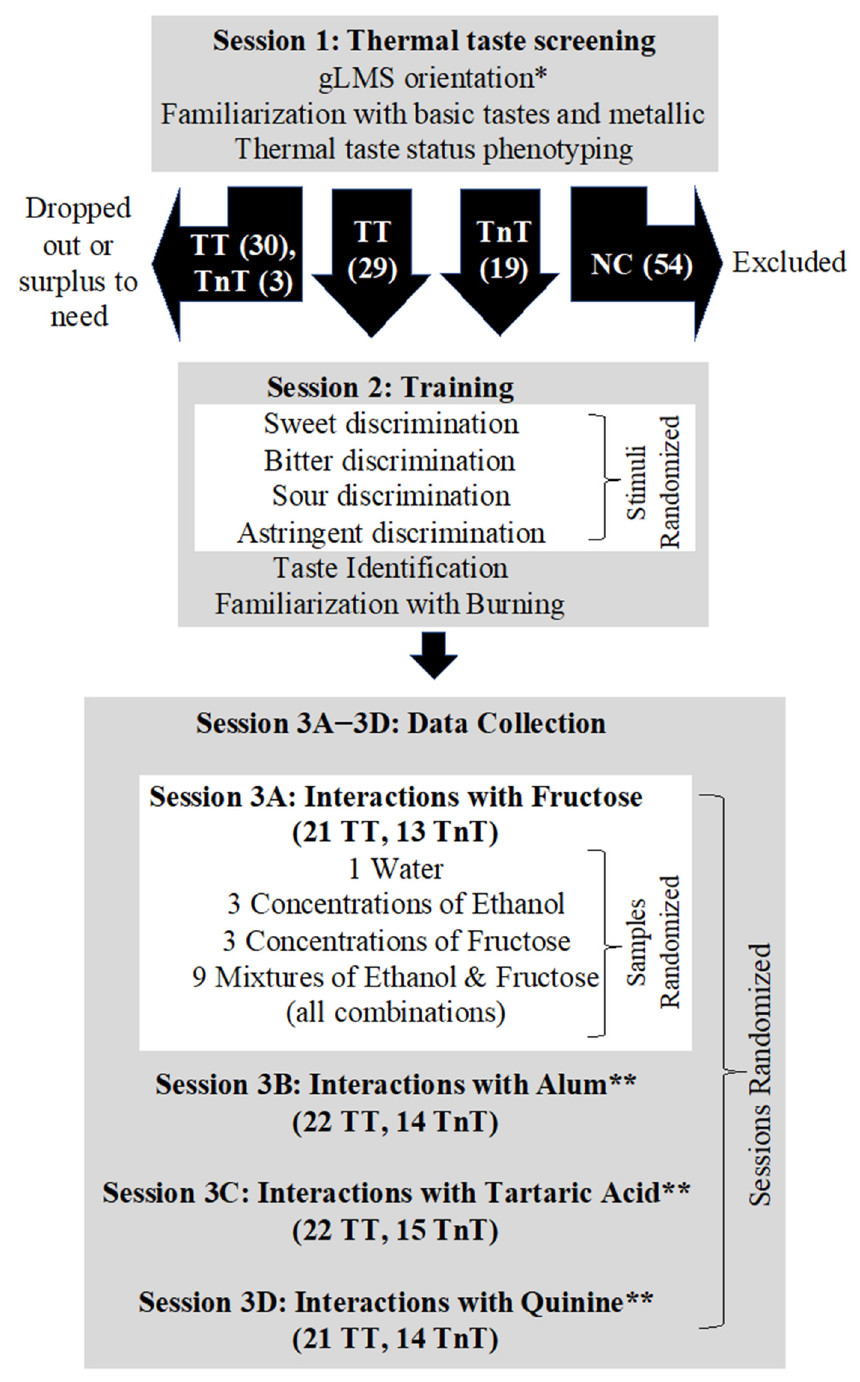
Figure 1. Overview of experimental design. (TT = thermal taster, TnT = thermal non-taster, NC = non-classifiable, * Note: Of the 142 eligible participants recruited to the study, only 135 completed Session 1. ** = Design per Session 3A except for unique stimulus compound).